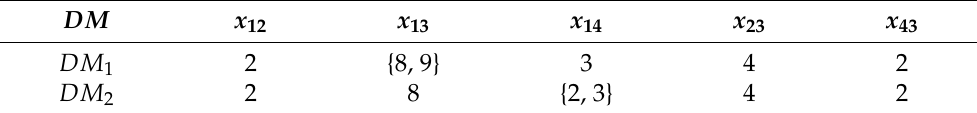
Table 4. Multi-choice preference comparisons of four criteria with two decision-makers in Example